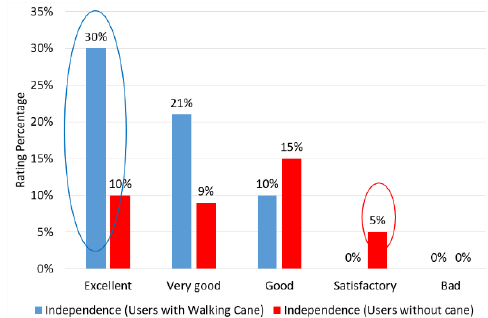
Figure 16. Detailed assessment of the two worst user-rated items.